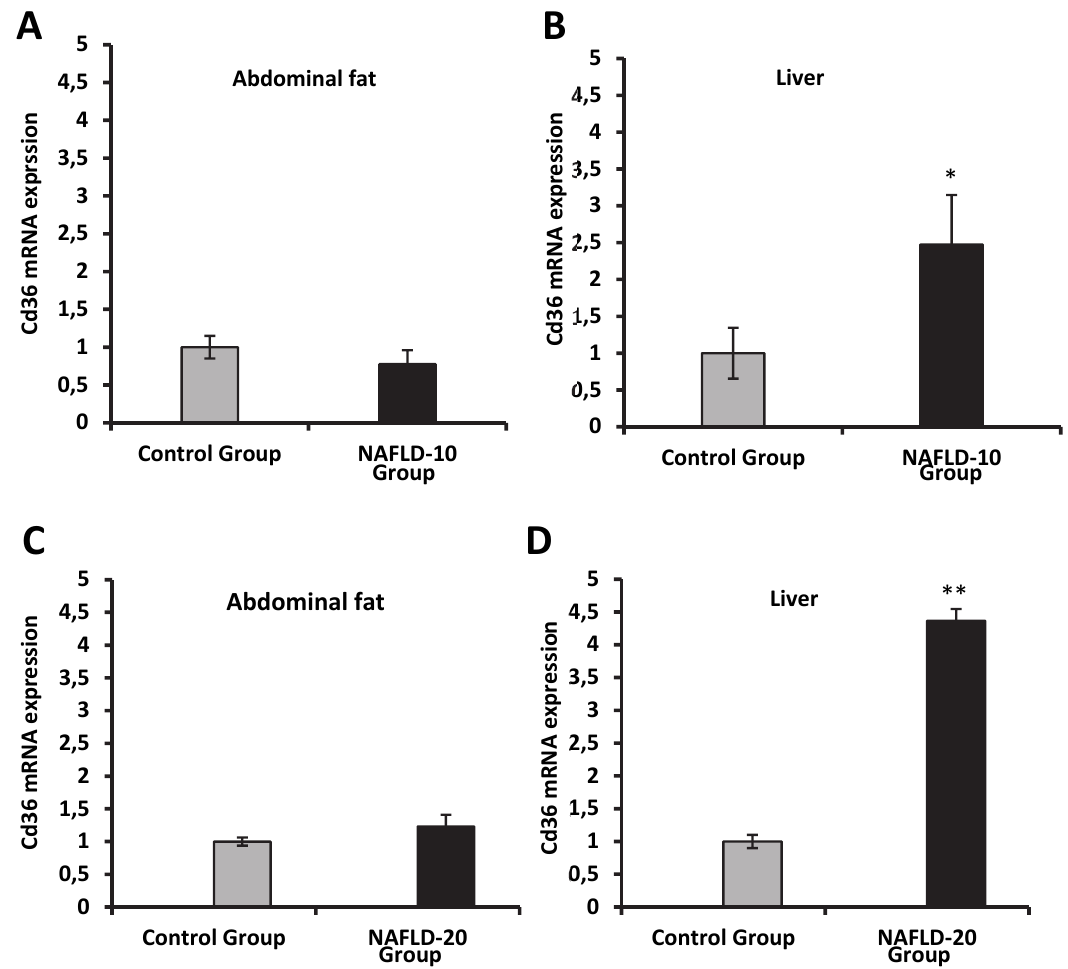
Fig. 5. Expression levels of Cd36 mRNA in adipose and hepatic tissues of rats consuming sucrose (NAFLD-10 and 20 groups) with respect to control rats. At 10 weeks, adipose (A) and hepatic tissue (B). At 20 weeks, adipose (C) and hepatic tissues (D). * P <0.05; ** P <0.01 versus control.